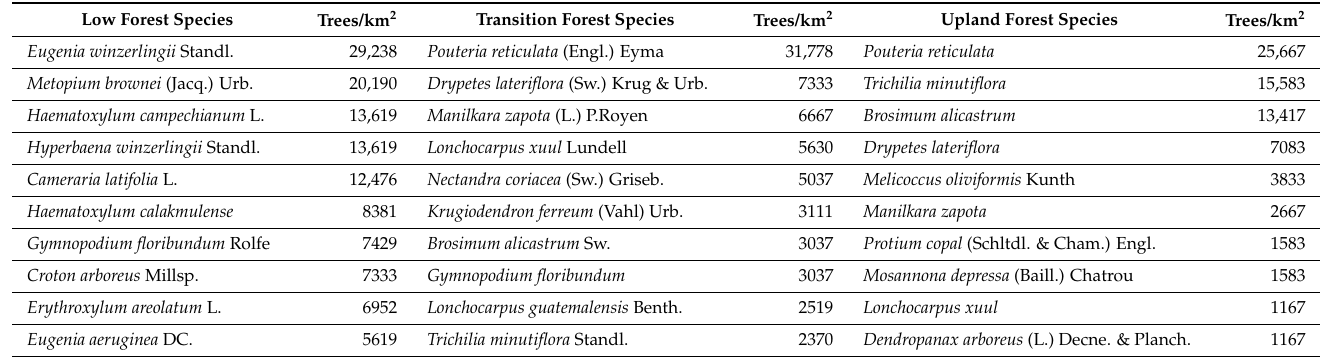
Table A1. Estimated number of trees per square kilometer for the most abundant species per vegetation type.